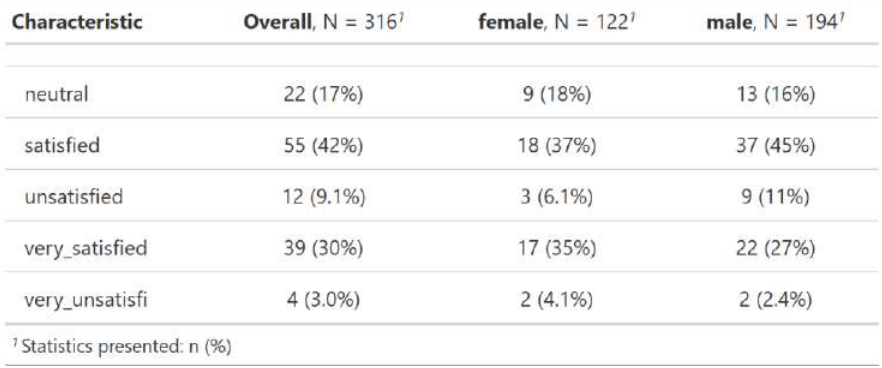
Table 10: How was your experience with a taxi, hotel, and the allied hospitality industry? (Source: Authors‟ depiction)